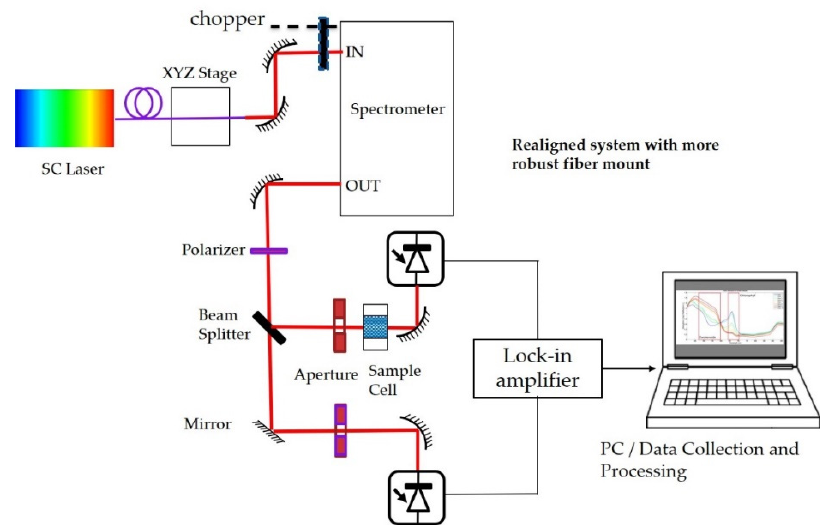
Figure 1. Block diagram of optical set-up for in vitro laboratory measurements.